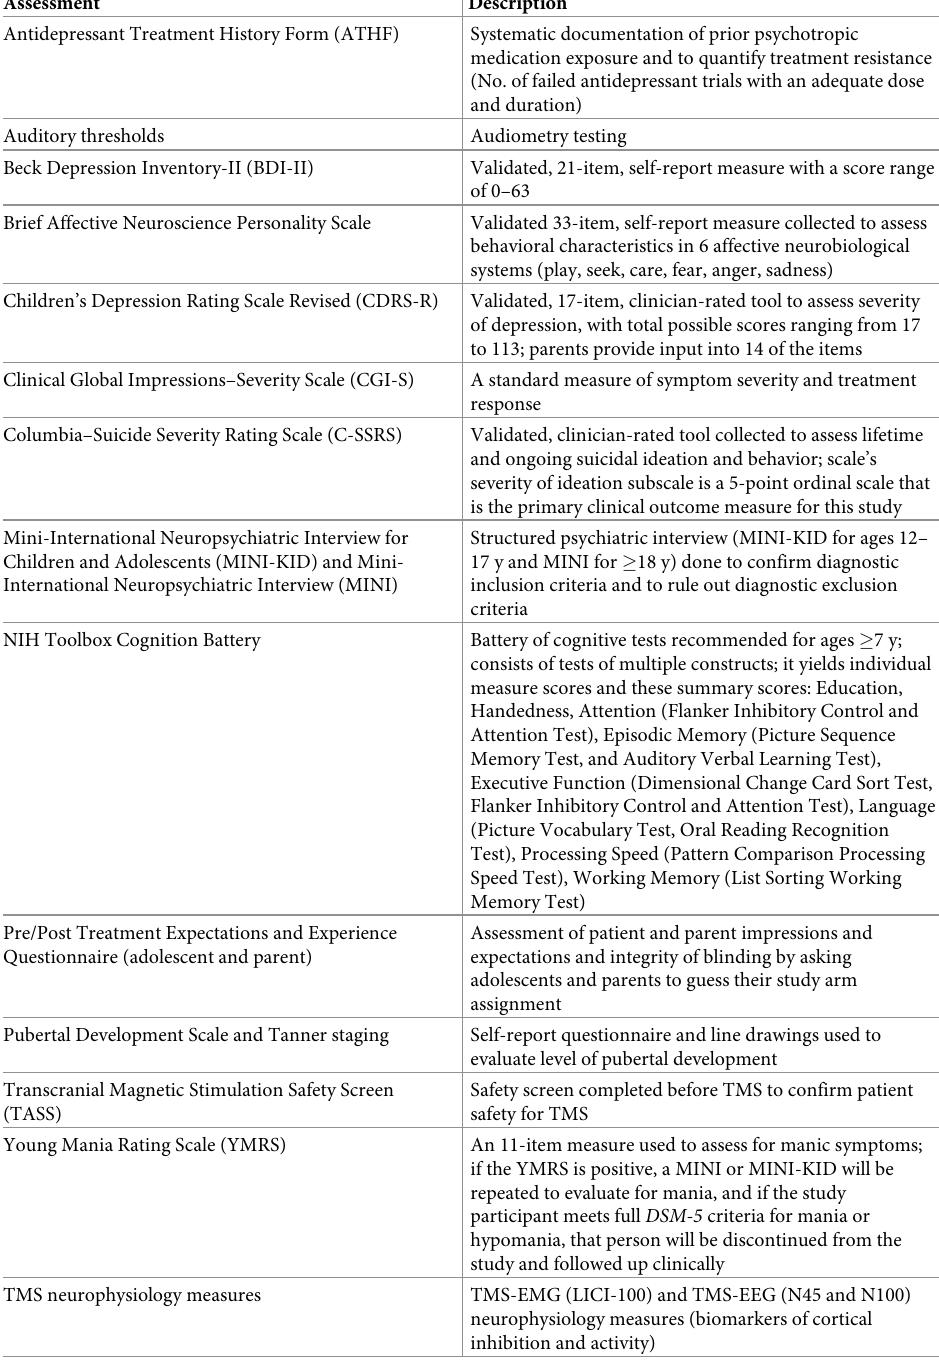
Table 2. Description of